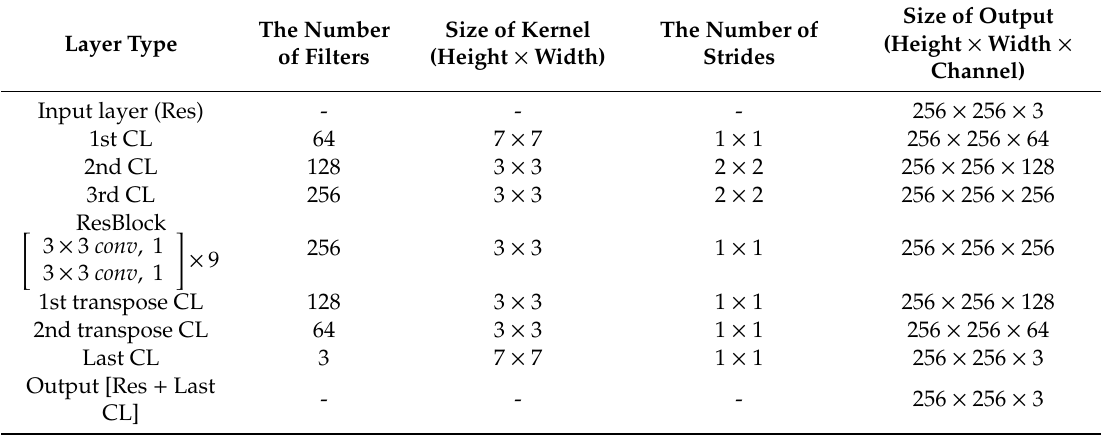
Table 2. DeblurGAN generator architecture (CL means convolutional